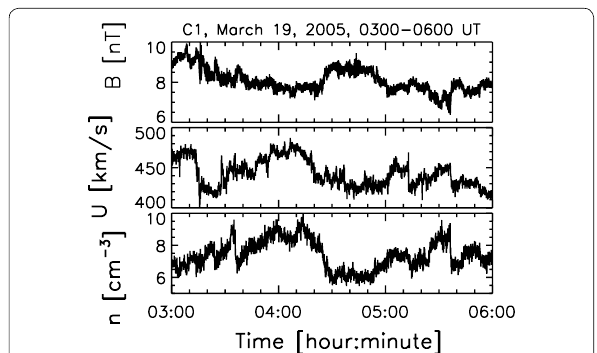
Fig. 3 Magnetic field magnitude, ion bulk velocity, and ion number density measured by Cluster-1 spacecraft in the solar wind on a